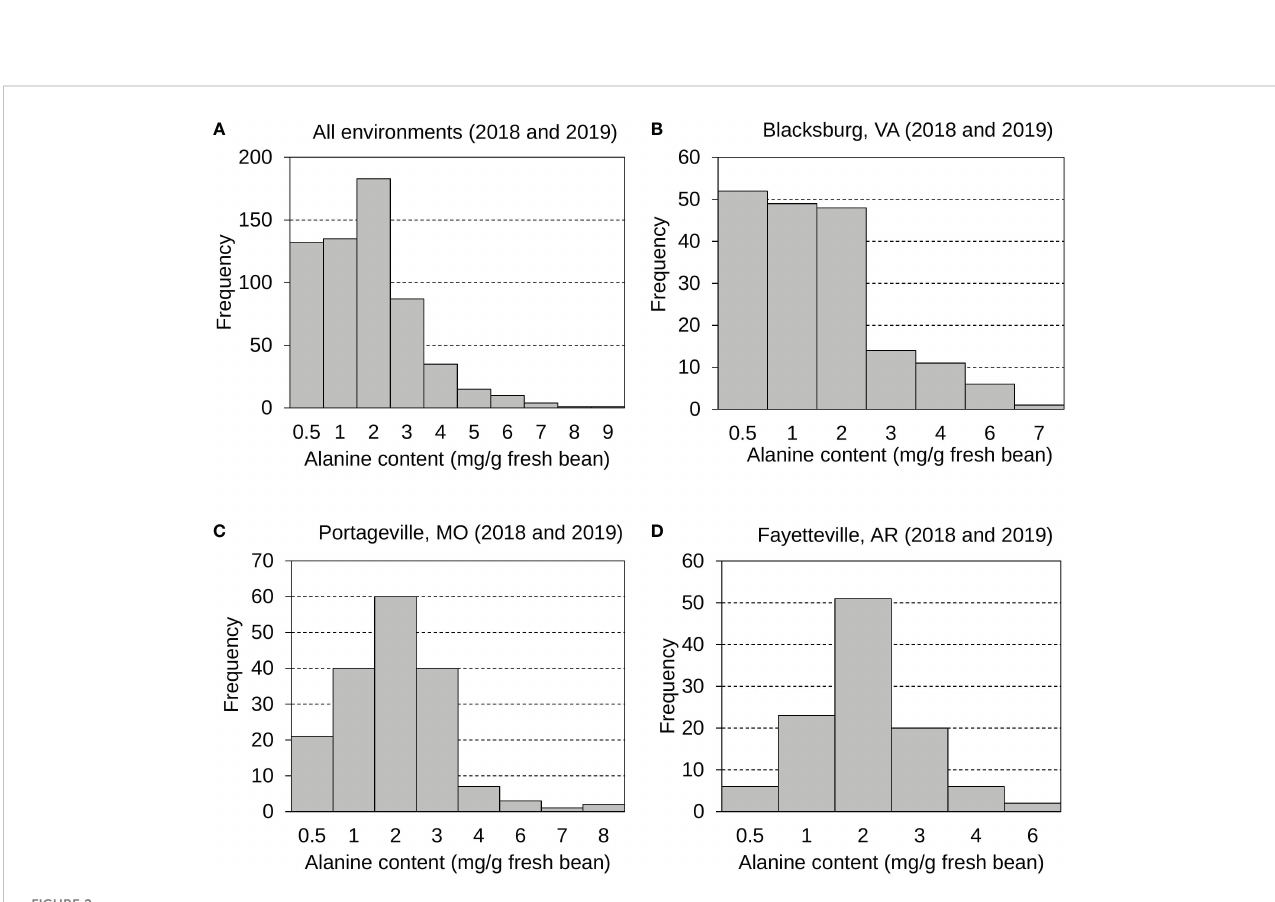
FIGURE 2 Frequency distributions displaying edamame bean proteinogenic Ala contents collected from all environments (A) , Blacksburg, VA (B) , Portageville, MO (C) , and Fayetteville, AR (D)